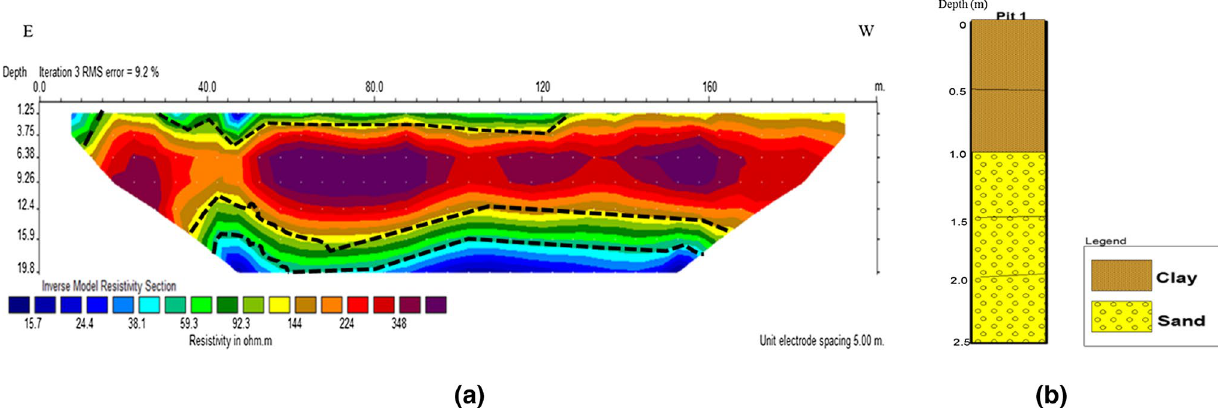
Fig. 4 Profile 1: a pseudosection of profile 1, b soil profile in pit